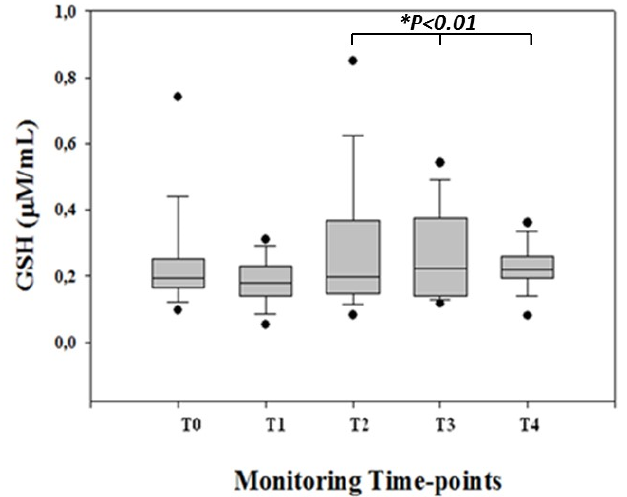
Figure 1. GSH concentrations (μM/mL) expressed as median and 5°–95° centiles at different monitoring time points: before the surgical procedure (T0); during the surgical procedure after sternotomy and before CPB (T1); at the end of CPB (T2); at the end of the surgical procedure (T3); and at 24 h after the surgical procedure (T4) in congenital heart disease children. GSH was significantly (* p < 0.01, for all) higher at T3 and T4 vs. T0 monitoring time points.